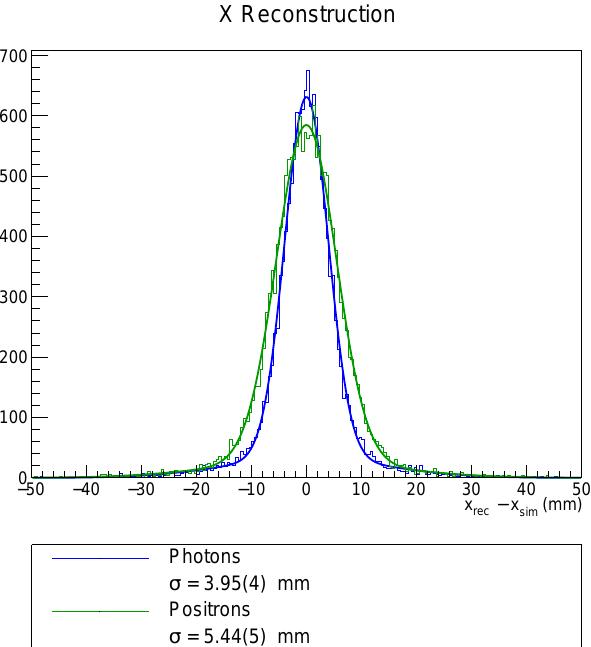
Figure 4. Position reconstruction in the x -direction for photons and positrons of 55MeV. The resolu- tion σ is obtained from a Gaussian